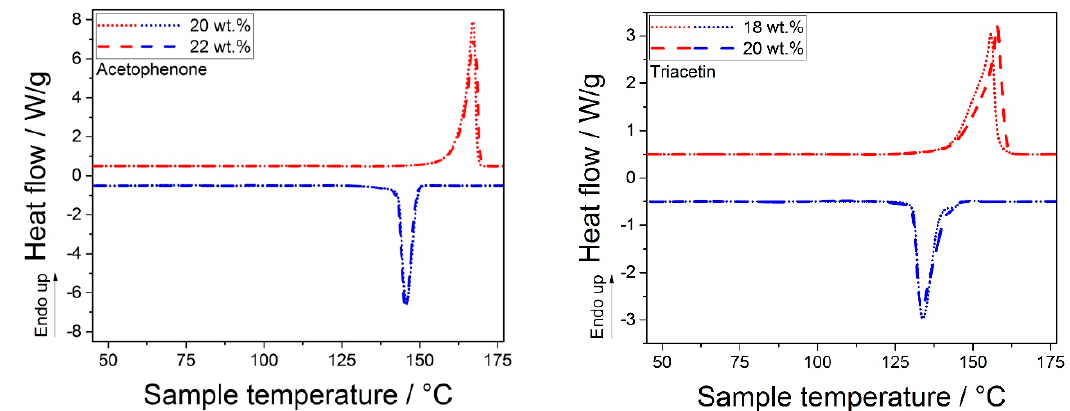
Figure 5. Thermograms of POM particles precipitated from acetophenone (left) and triacetin (right).